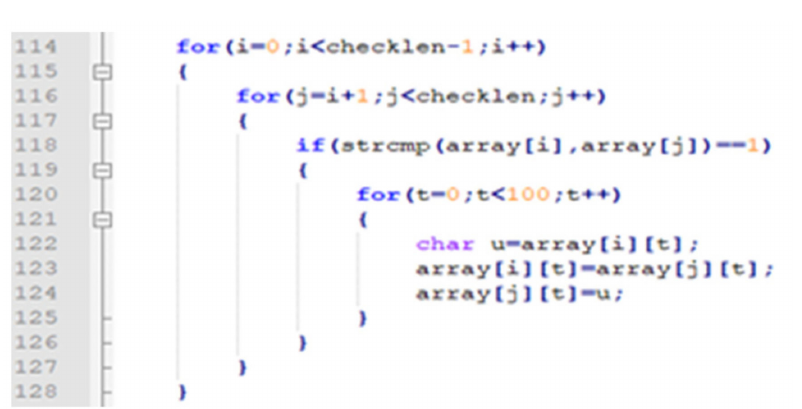
Figure 20. Test result (3).